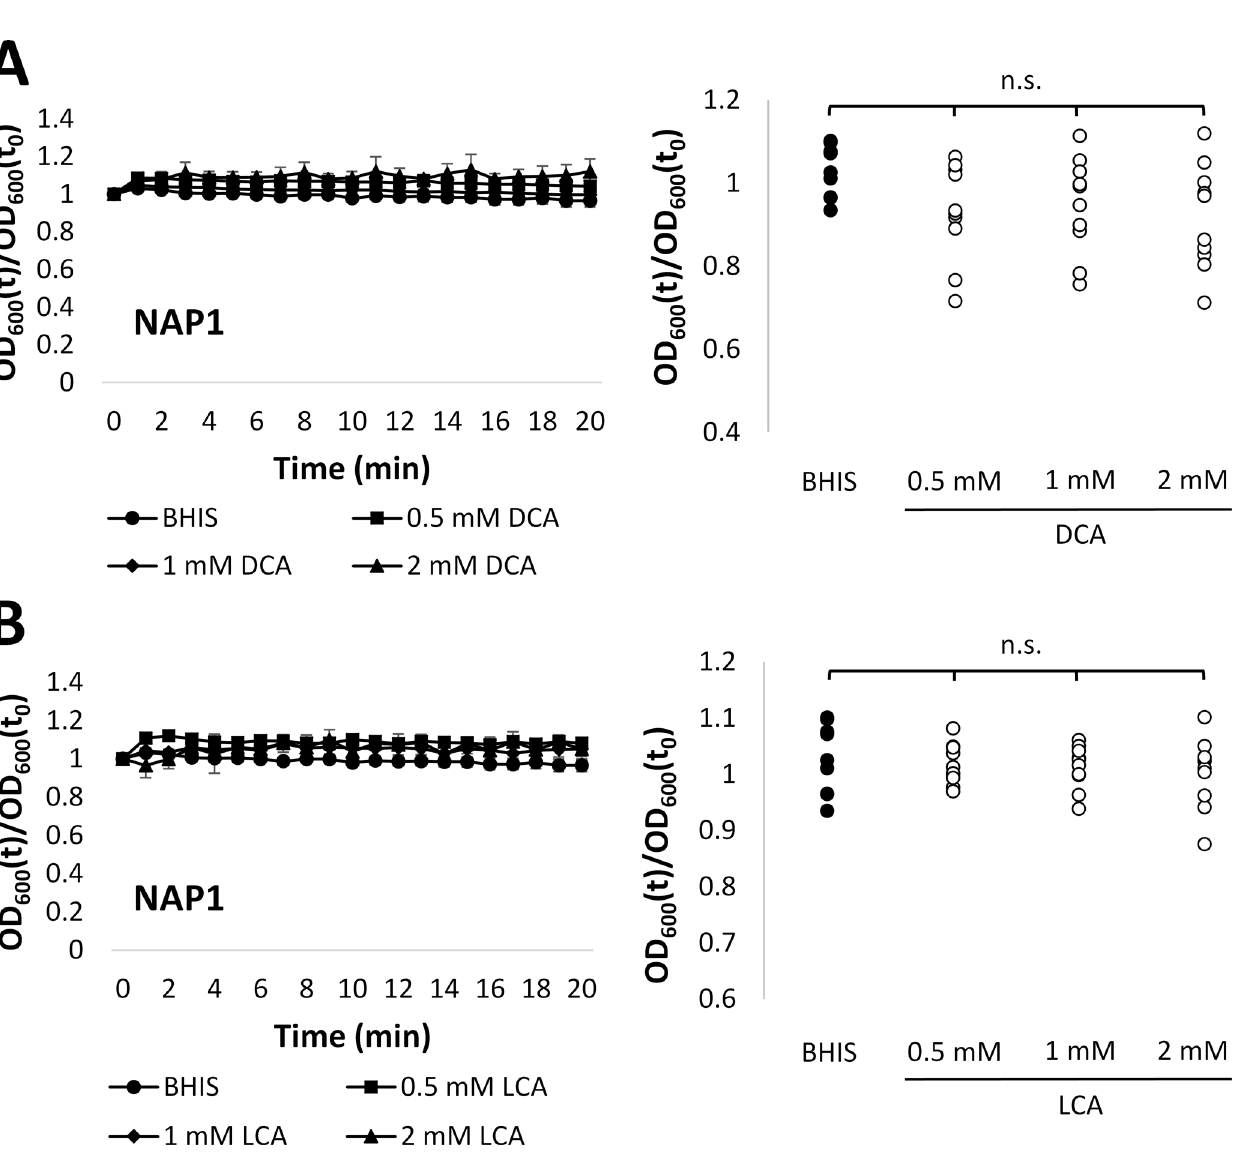
Fig 3. C . difficile spores do not germinate in response to secondary bile acids. A) (Left Panel) Relative OD 600 of NAP1 spores exposed to 0.5 mM (square), 1 mM (diamond), or 2 mM (triangle) DCA versus BHIS alone (circle). (Right Panel) Relative OD 600 of spores from 10 isolates after 20 min exposure to 0.5, 1, or 2 mM DCA vs. BHIS alone. B) (Left Panel) Relative OD 600 of NAP1 spores exposed to 0.5 mM (square), 1 mM (diamond), or 2 mM (triangle) LCA versus BHIS alone (circle). (Right Panel) Relative OD 600 of spores from 10 isolates after 20 min exposure to 0.5, 1, or 2 mM LCA vs. BHIS alone. OD 600 (t)/OD 600 (t 0 ) = OD 600 normalized to initial OD 600 (relative OD 600 ). Legend: n.s. = non-significant. BHIS = BHI with yeast extract and L-cysteine; DCA = deoxycholate; and LCA = lithocholic acid. Data represent mean ±